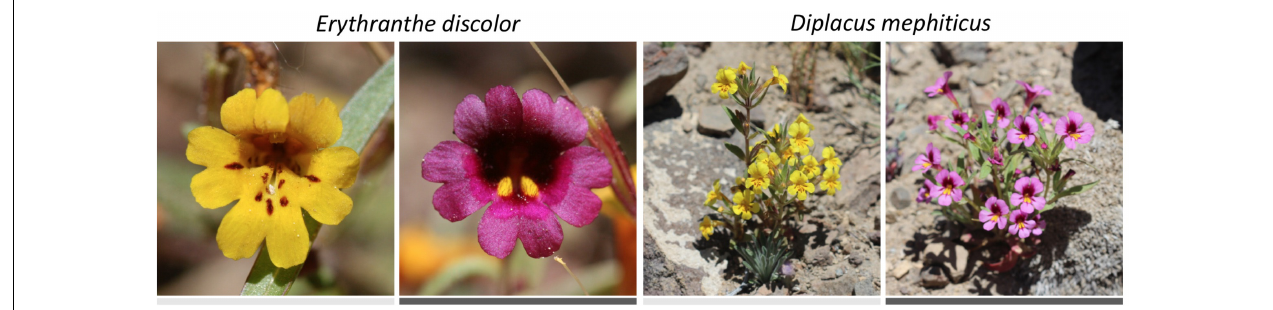
FIGURE 1 | Two focal species that are polymorphic for floral pigments: Erythranthe discolor and Diplacus mephiticus . Pink-flowered morphs have anthocyanin pigments expressed throughout the corolla tissue, whereas expression is lacking in yellow-flowered morphs.